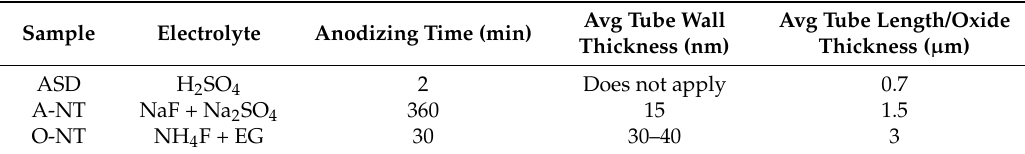
Table 1. Summary of oxides characteristics as emerges from SEM